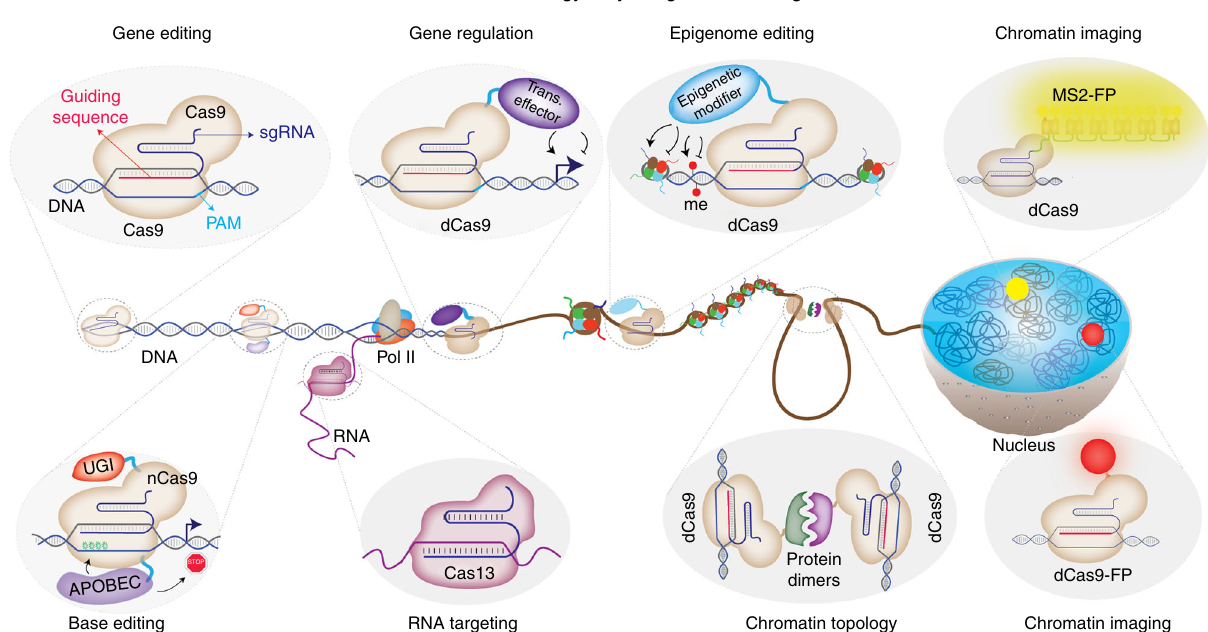
Fig. 3 Major application areas of CRISPR-Cas-based technologies beyond genome editing. While WT Cas9 enables genome editing through its guidable DNA cleavage activity, catalytically impaired Cas9 enzymes have been repurposed to achieve targeted gene regulation, epigenome editing, chromatin imaging, and chromatin topology manipulations. Furthermore, the catalytically impaired nickase Cas9 enzyme has been used as a platform for base editing without double strand breaks. In addition to DNA-targeting Cas proteins, novel RNA-targeting CRISPR/Cas systems have been described as